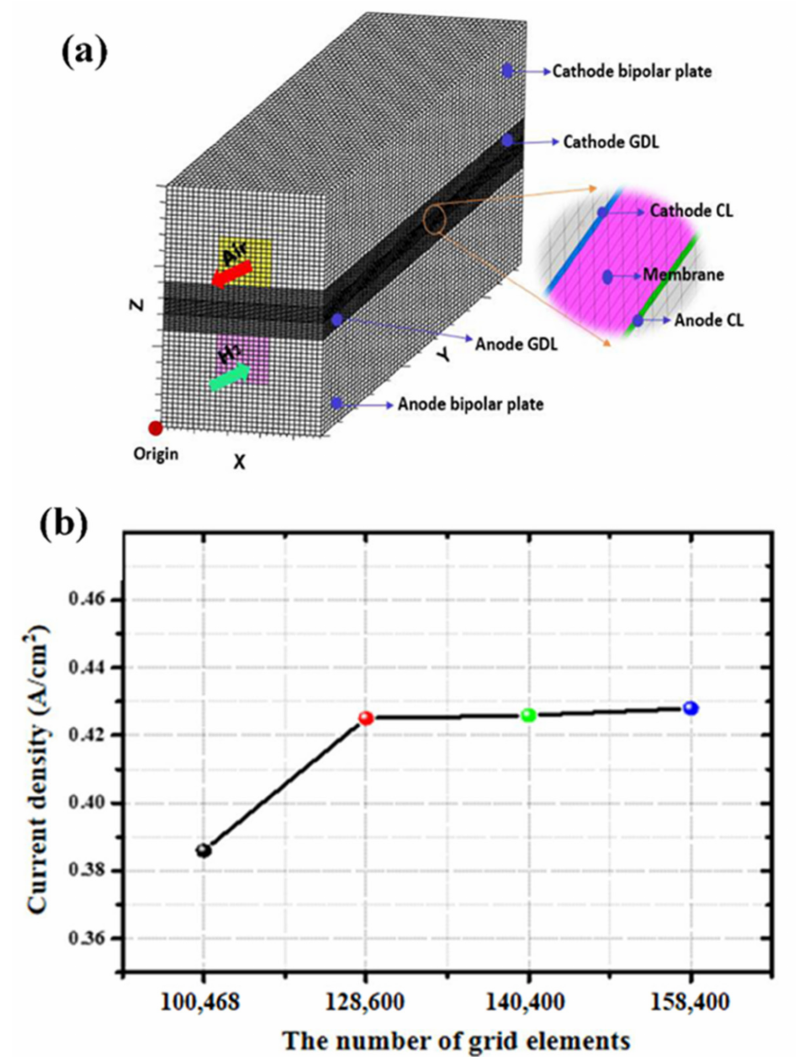
Figure 1. Grid related: ( a ) meshing of computational domain, ( b ) validation of grid